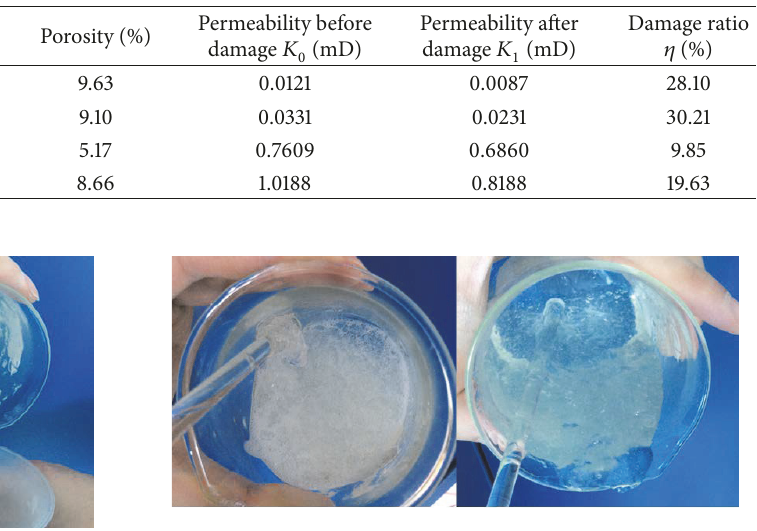
Figure9:Cross-linkingofguarwith500ppmMgCl 2